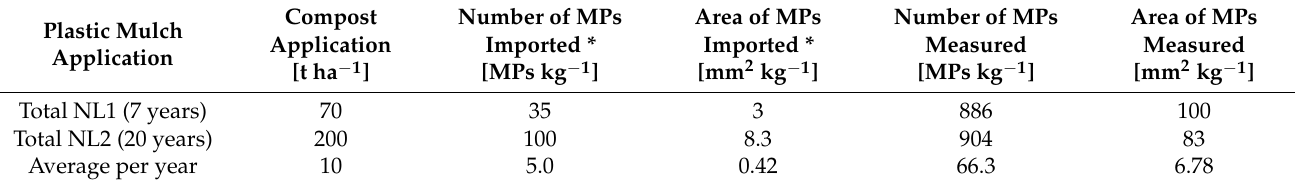
Table 4. Estimation of the plastic input from the compost application in the Dutch farms (NL1 and NL2). Plastic Mulch